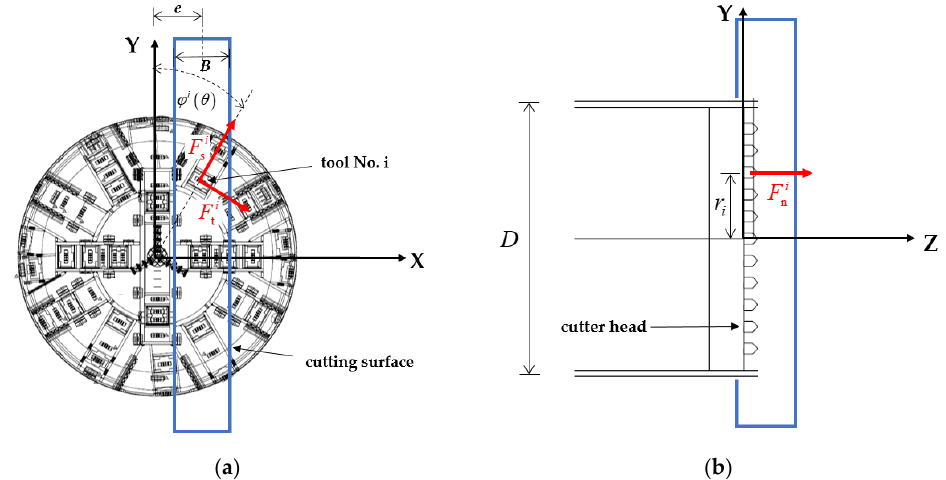
Figure 4. Schematic diagram of calculation model: ( a ) Front view; ( b ) Side view.